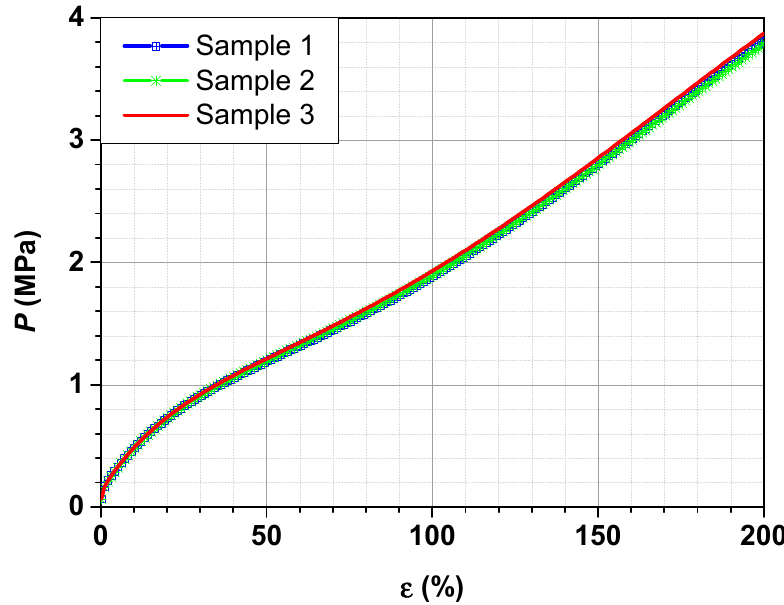
Figure 3. Stress–strain curves measured in tensile for styrene butadiene rubber (styrene butadiene rubber (SBR) filled with 70 phr carbon black N234 at room temperature and a crosshead speed of 10 mm/min.